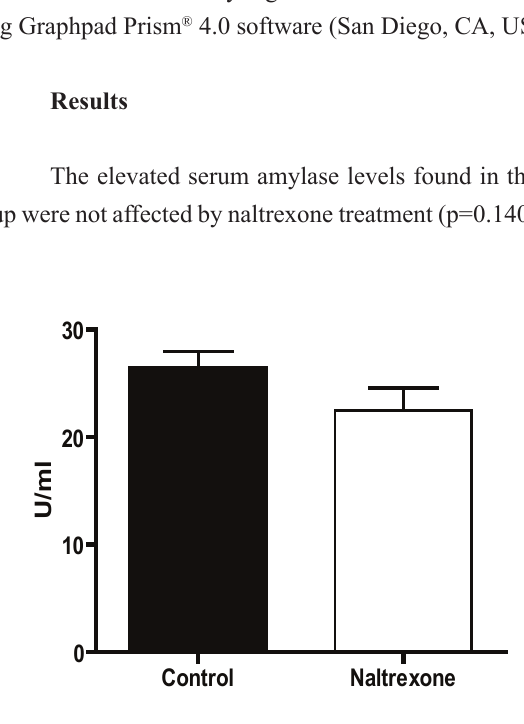
FIGURE 1 - Serum levels of amylase. AP was induced in rats